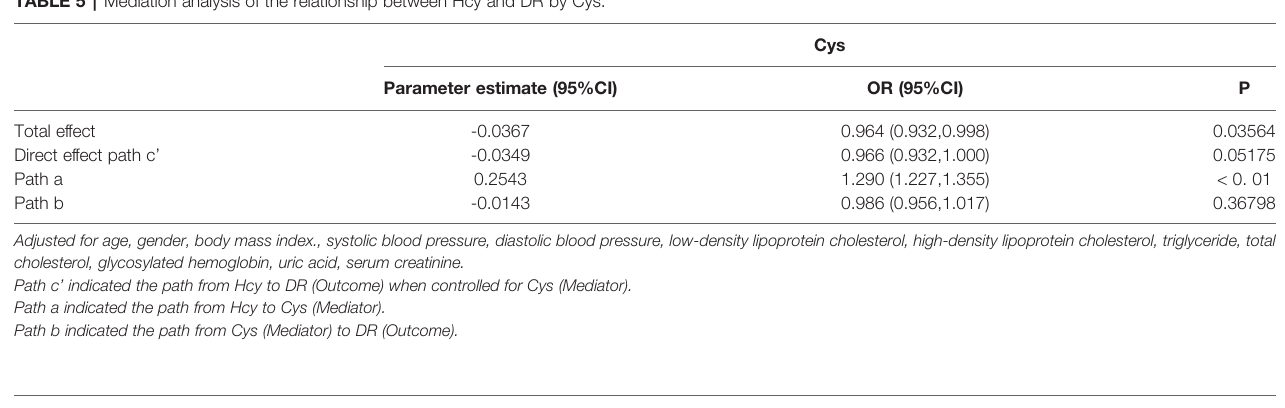
Adjusted for age, gender, body mass index., systolic blood pressure, diastolic blood pressure, low-density lipoprotein cholesterol, high-density lipoprotein cholesterol, triglyceride, total cholesterol, glycosylated hemoglobin, uric acid, serum creatinine. Path c ’ indicated the path from Met to DR (Outcome) when controlled for Hcy (Mediator). Path a indicated the path from Met to Hcy (Mediator). Path b indicated the path from Hcy (Mediator) to DR (Outcome).